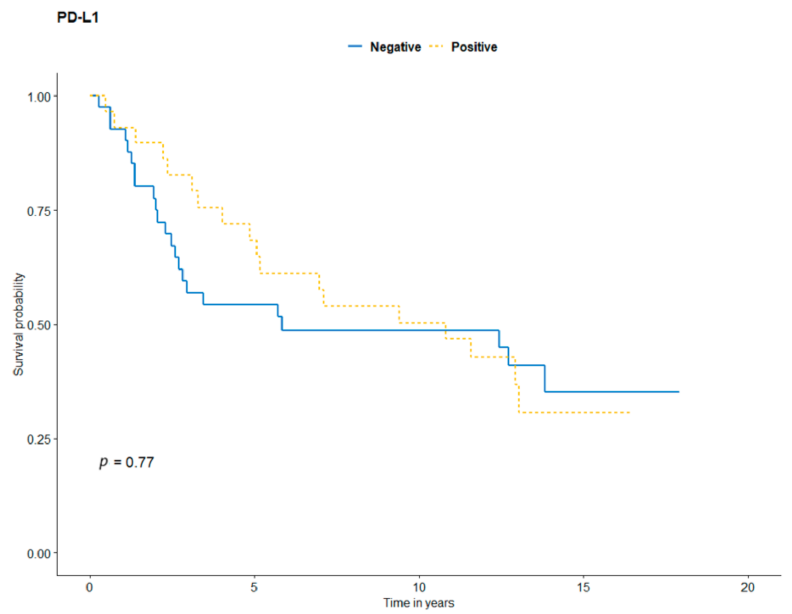
Figure 5. Kaplan-Meier survival curves for programmed death-ligand 1 (PD-L1) expression on acral melanoma and overall survival. Table 4. Univariate analysis of immunohistochemical features. Statistical significance ( p ≤ 0.05) is marked with *.